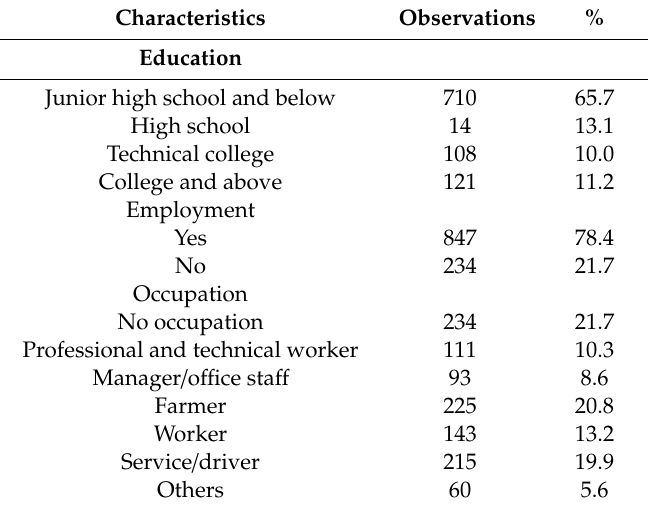
Table 2. Basic characteristics of the mothers.